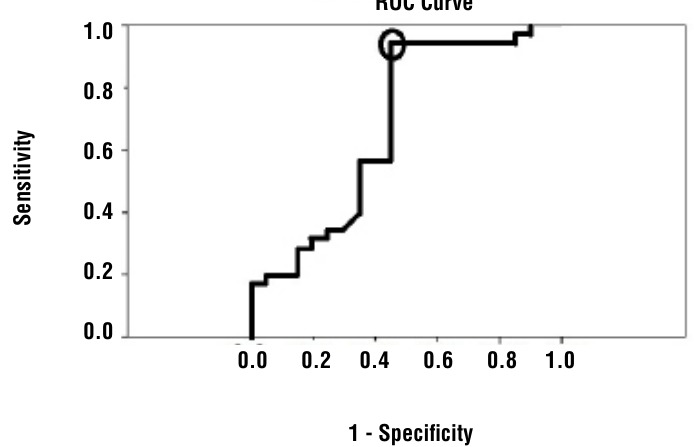
Figure 2 - Cut off value of urinary CA 19-9 as deduced from ROC Curve.